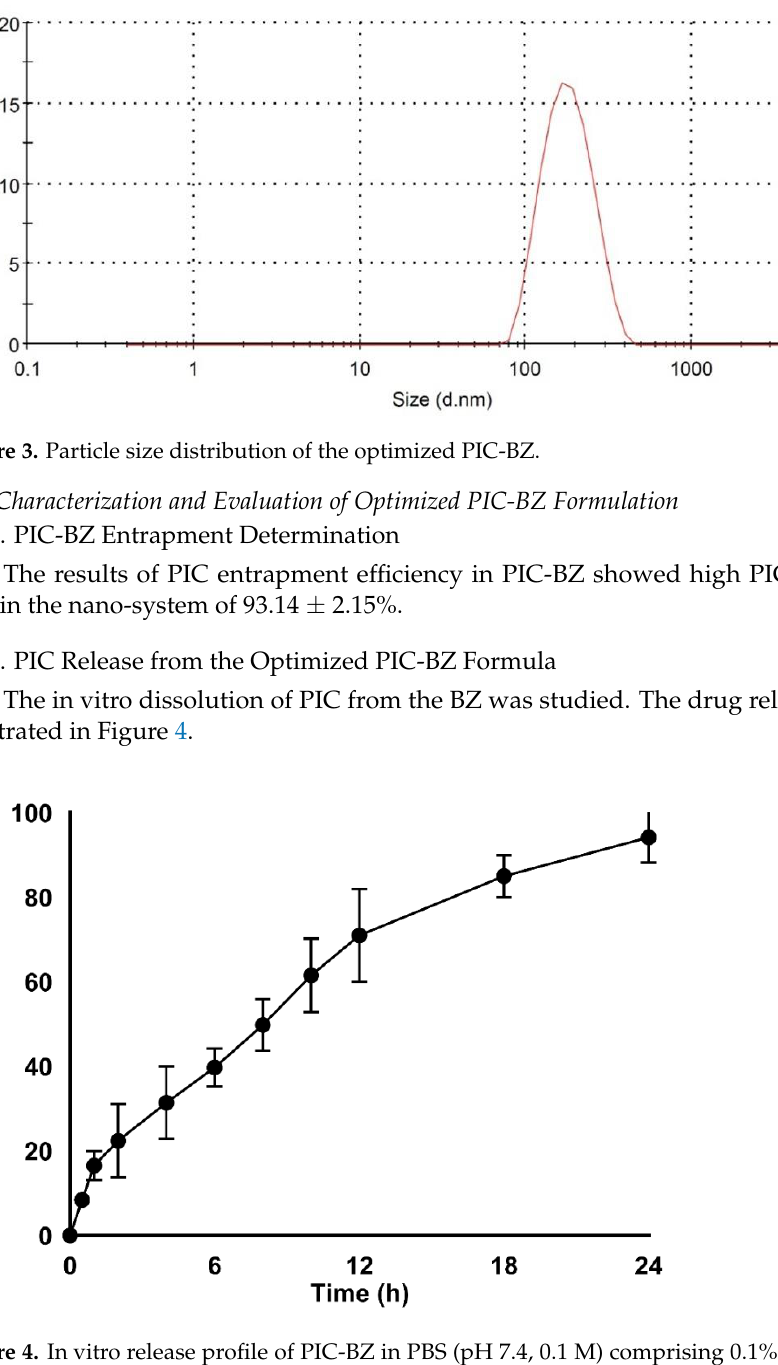
Figure 4. In vitro release profile of PIC-BZ in PBS (pH 7.4, 0.1 M) comprising 0.1% of Tween 80 at 37 ± 0.5 °C.